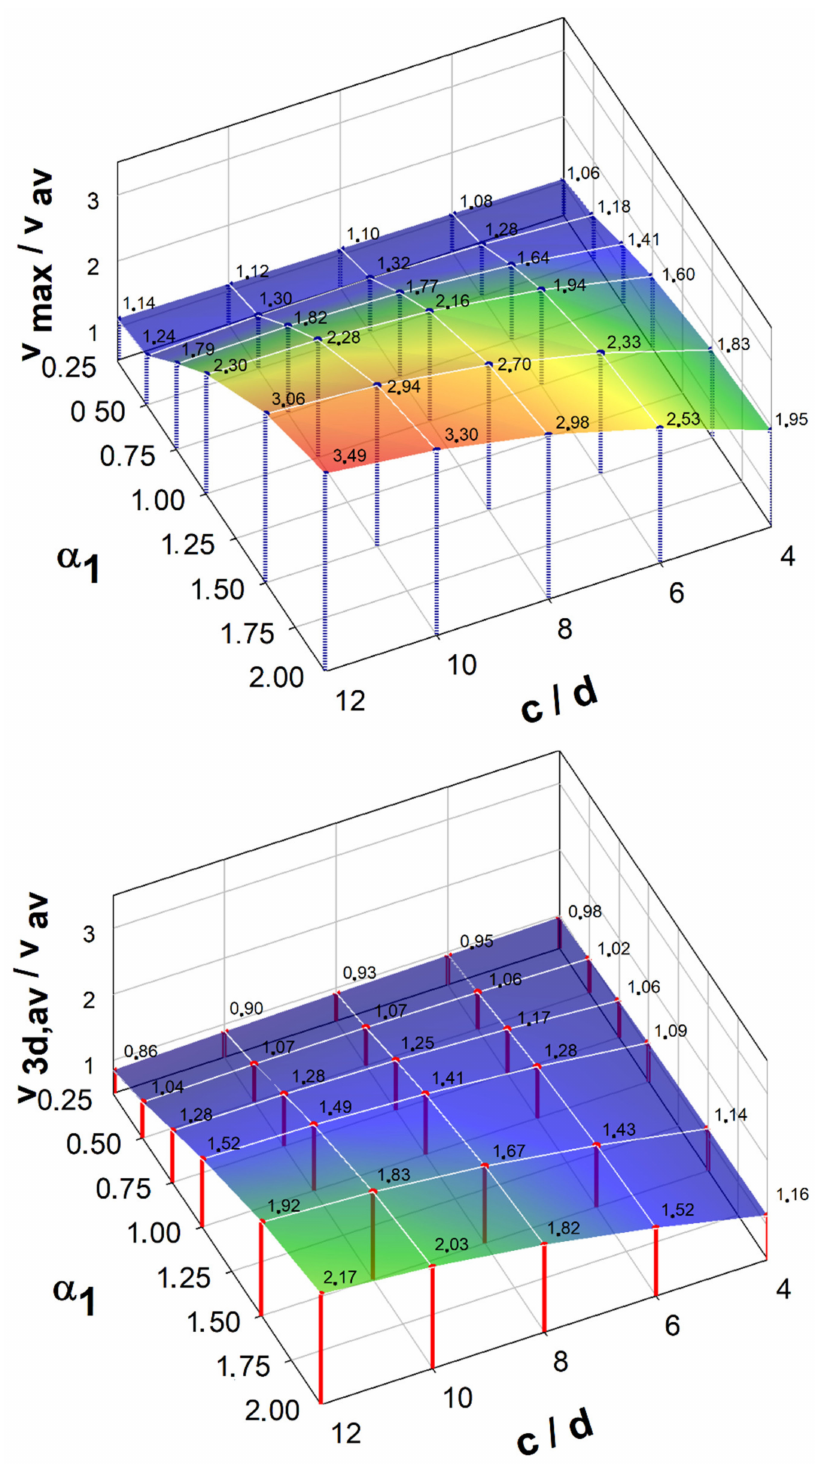
Figure 10. Influence of the dimensions of the shear caps and their stiffness on the distribution of shear forces in the control perimeter located at a distance of 0.5 d from the face of the shear